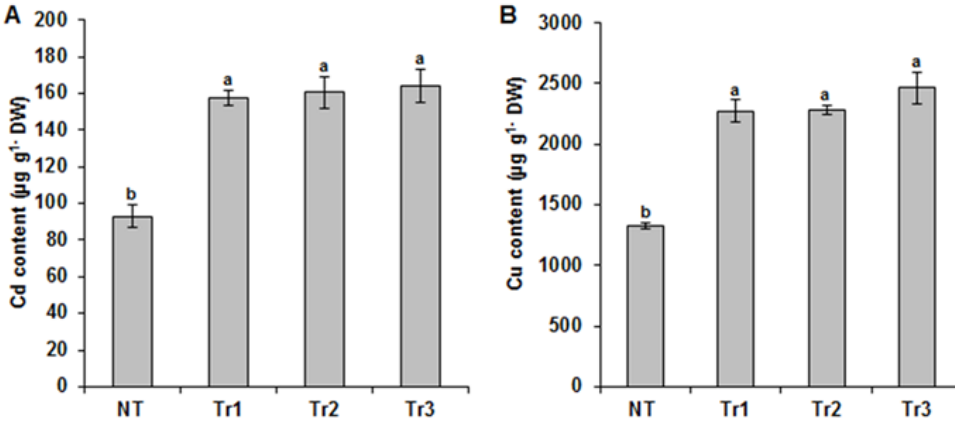
Figure 5. Cd ( A ) and Cu ( B ) accumulation in LmTrxh2 -overexpressing tobacco lines and NT plants. Plants were cultivated for 15 days on MS medium supplemented with or without Cd or Cu. The means denoted by the same letter were not significantly different at p < 0.05.